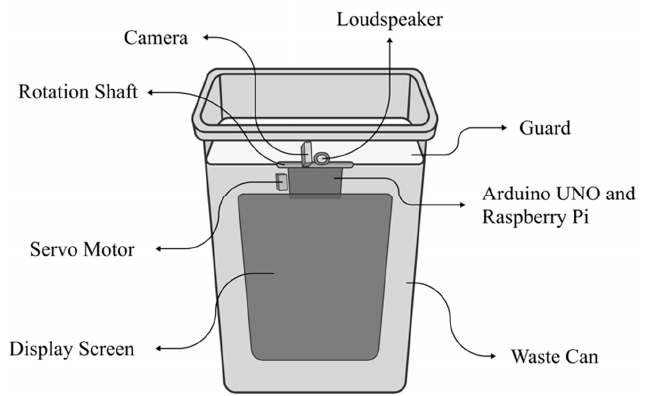
Figure 3. Components of the designed intelligent trash can.